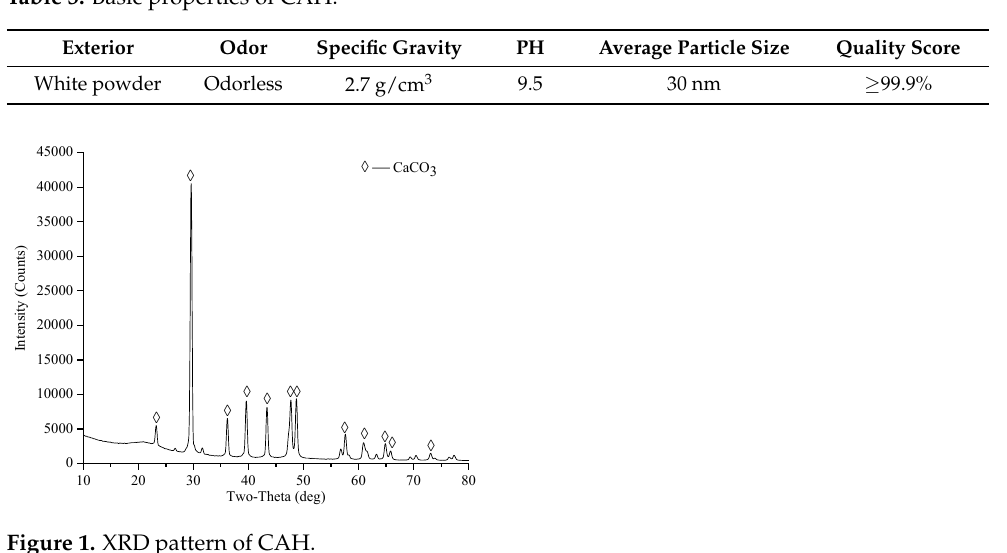
Table 3. Basic properties of CAH.